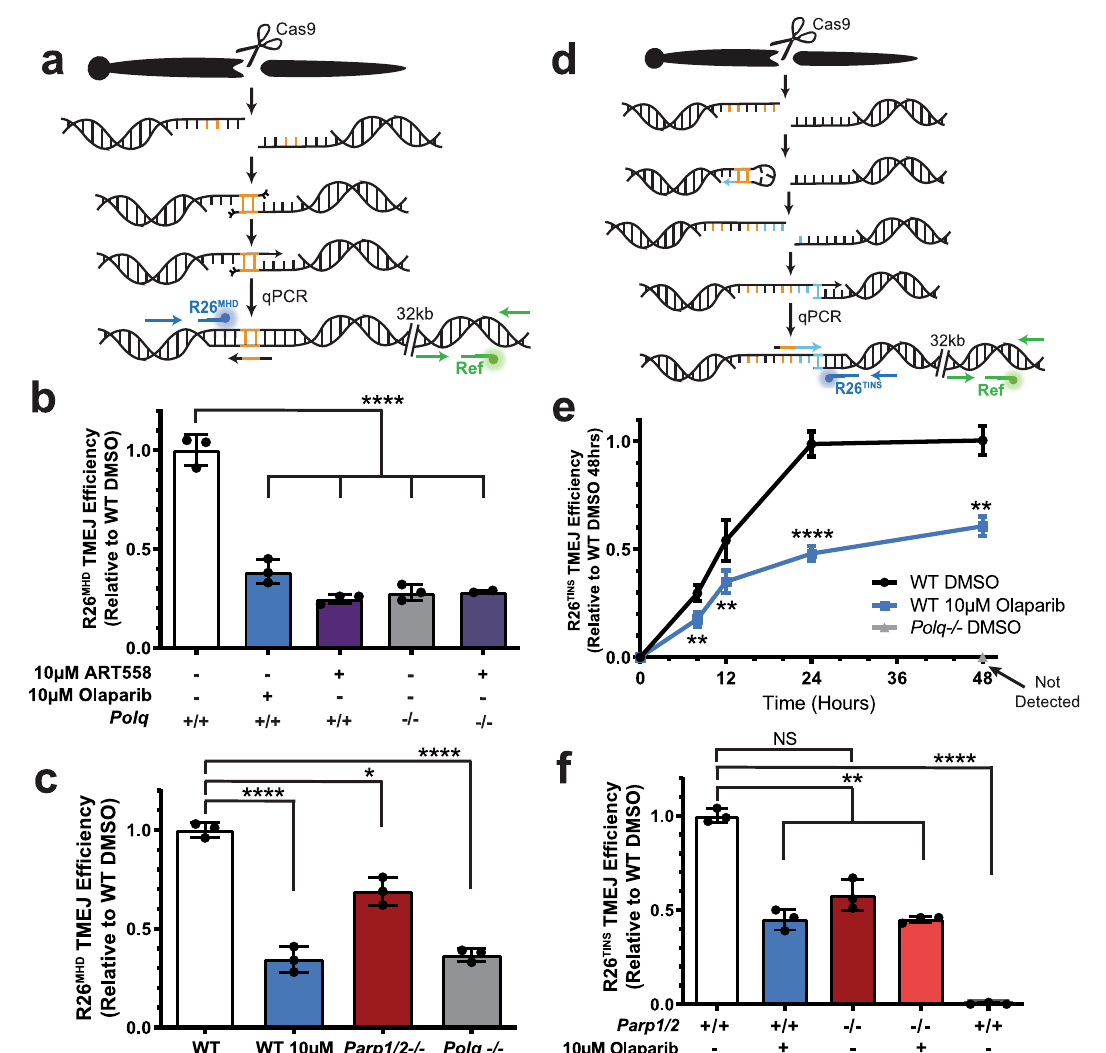
Fig. 2 | Loss of PARP activity partially inhibits chromosomal TMEJ. a Model of the formation of the microhomology (orange) mediated deletion signature TMEJ repair product (R26 MHD ) and its detection by qPCR. The location of primers and probe is identi fi ed for the R26 MHD amplicon in blue and the reference amplicon in green. b , c R26 MHD TMEJef fi ciencyafter24hcomparingDMSO-treatedWTor Polq-/- MEFstoMEFstreatedwitholapariborART558( b ,**** p <0.0001)or Parp1/2-/- MEFs ( c , * p =0.014, **** p <0.0001). d Model of the formation of the templated